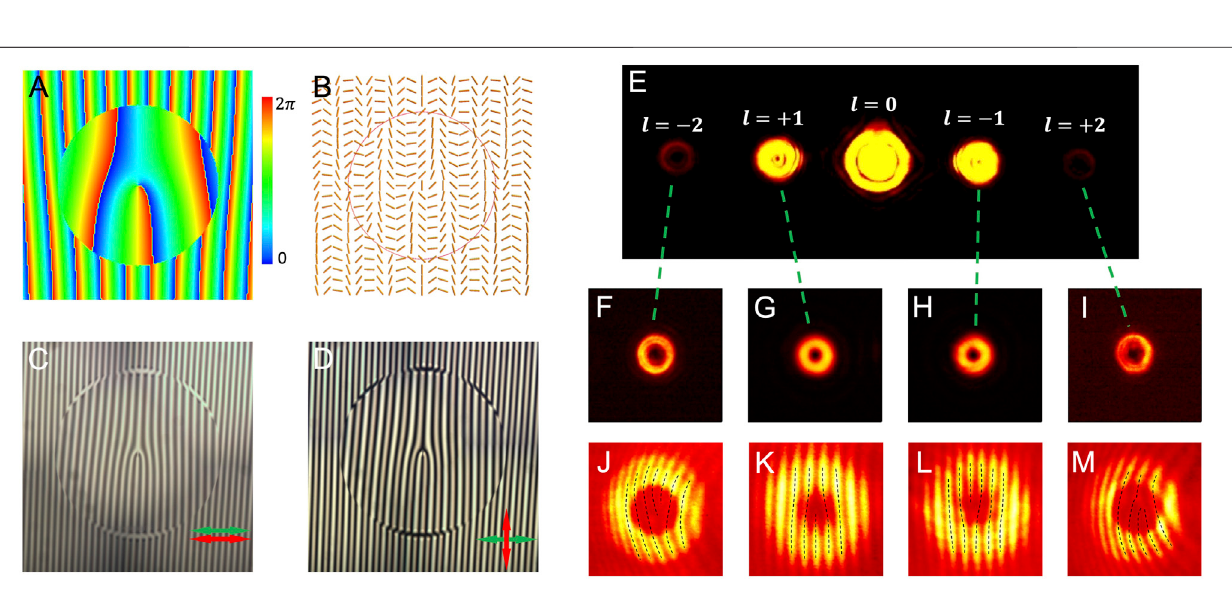
Frontiers in Physics |